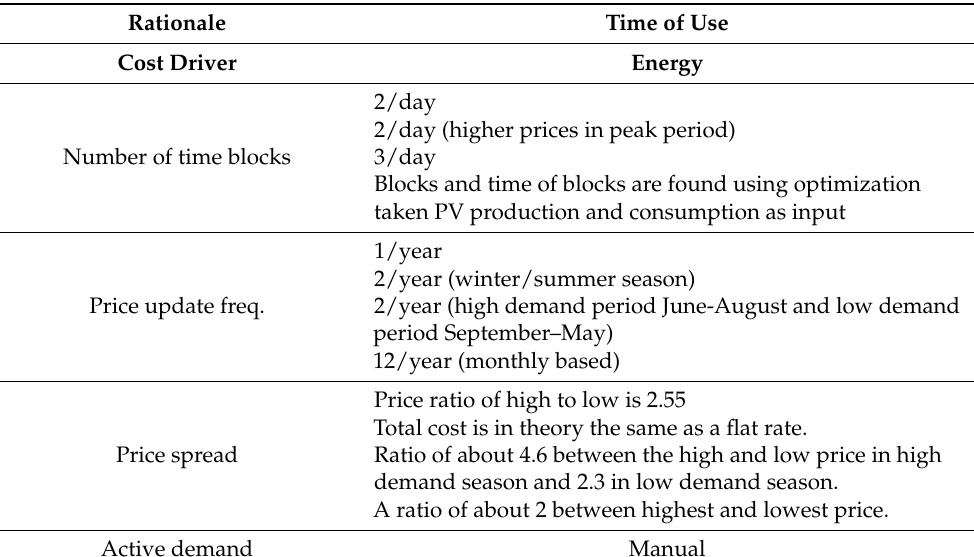
Price ratio of high to low is 2.55 Total cost is in theory the same as a flat rate. Ratio of about 4.6 between the high and low price in high Price spread demand season and 2.3 in low demand season. A ratio of about 2 between highest and lowest